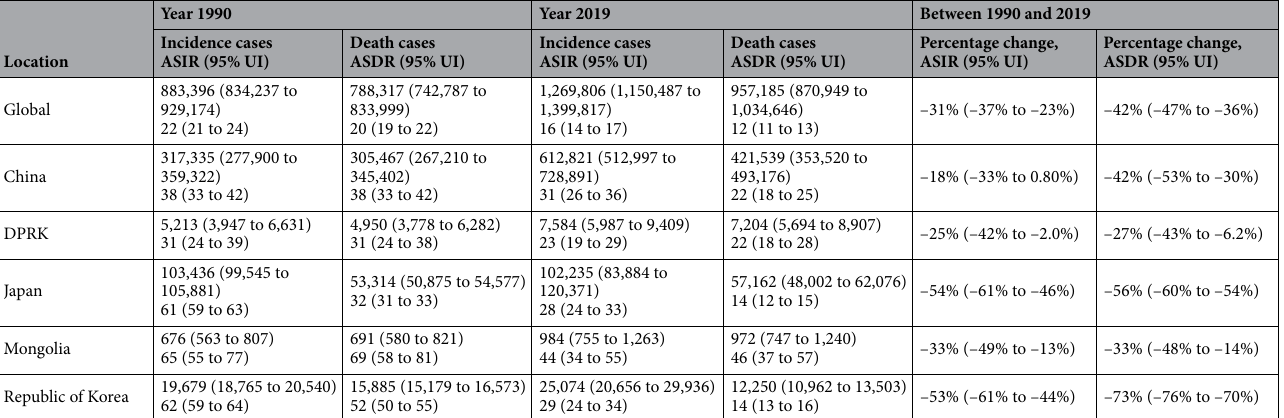
Table 1. Incidence and deaths with percentage changes of gastric cancer for both sexes, between 1990 and 2019. ASDR age-standardized death rate per 100,000 person-years, ASIR age-standardized death rate per 100,000 person-years, DPRK Democratic People’s Republic of Korea, UI uncertainty